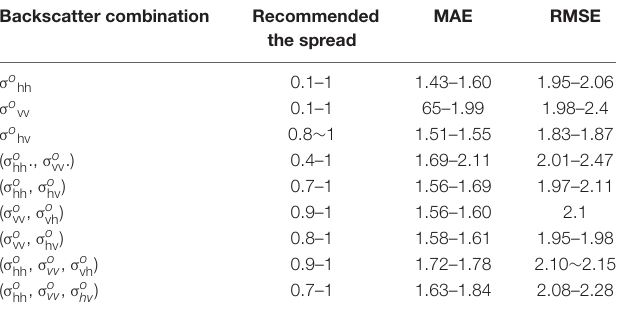
TABLE 3 | The recommended backscatter models, spread parameters, and their performance metrics. Backscatter combination Recommended the spread